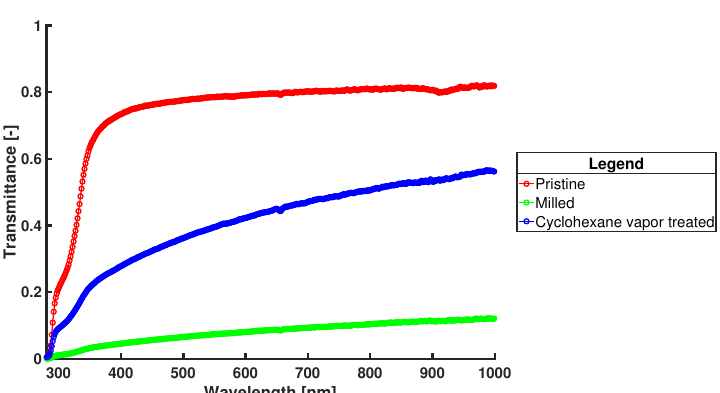
Figure 10. Graph of the transmittance data for a pristine substrate, and the substrates of Figure 9a,b showing the improvement in optical transparancy after cyclohexane vapor post-treatment. The red line is for pristine COC, the green line for milled COC, and the blue line for cyclohexane vapor post-treated COC. Measurements are done with a Woollam M-2000UI ellipsometer in transmittance